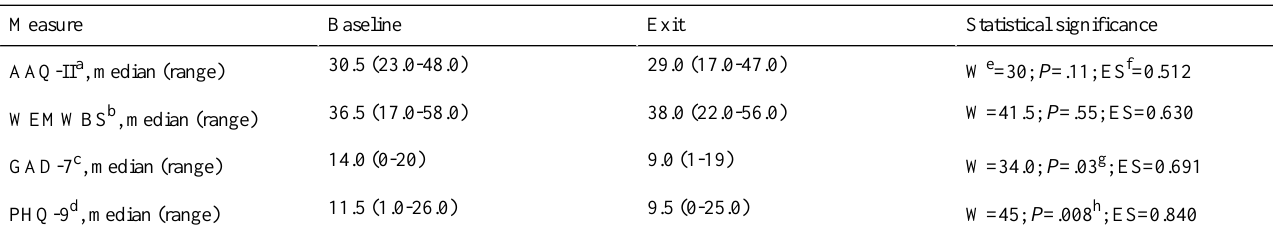
Table 3. Preliminary efficacy in participants (N=10) of the digital intervention. The clinical cutoff for GAD-7 and PHQ-9 for moderate anxiety or depression, respectively, is 10.